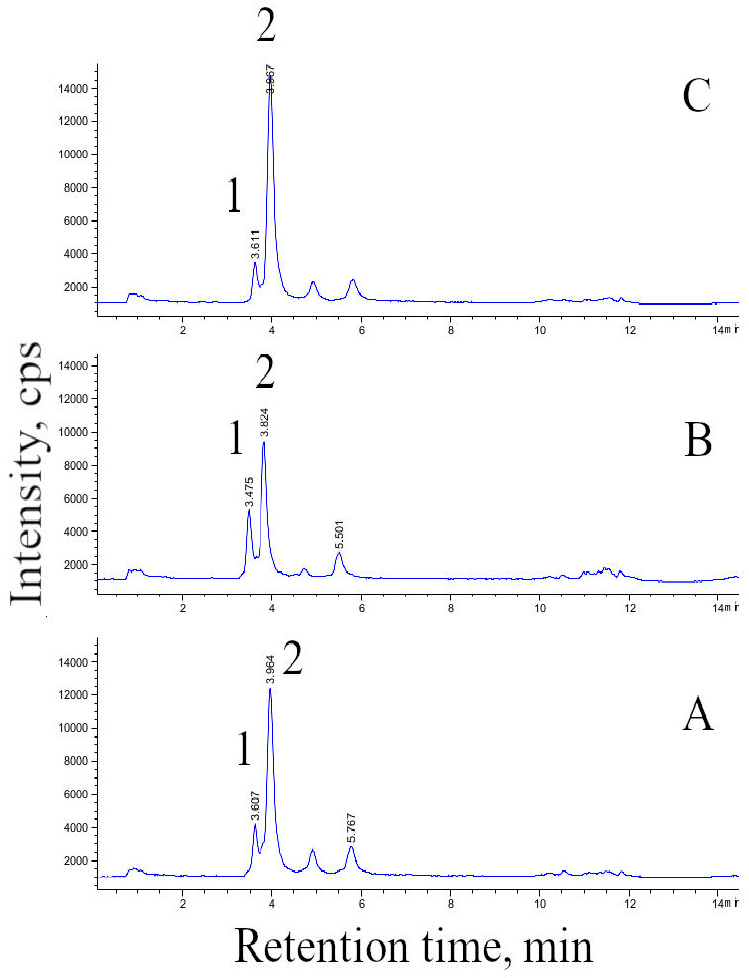
Figure 2. The HPLC–MS profiles of extracts from Dioscorea deltoidea cell biomass grown in different cultivation systems. ( A )—flasks, ( B )—20 L bioreactor, ( C )—630 L bioreactor. 1—deltoside (protodeltonin), 2—protodioscin.